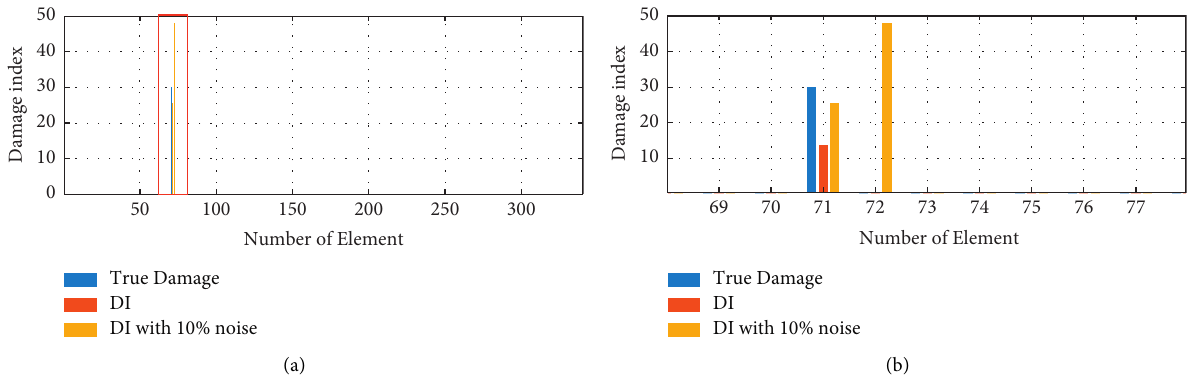
Figure 17: Results of single-damage scenario D1 containing 10% measurement noise. (a) Original result. (b) Zoomed result.